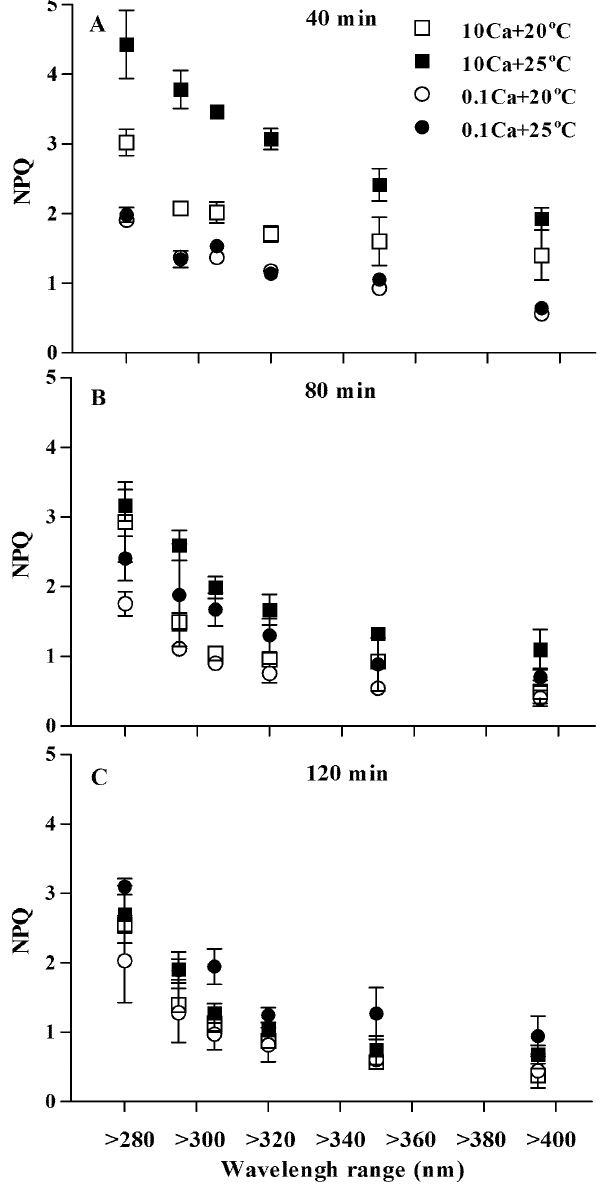
Fig. 4. Non photochemical quenching (NPQ) of Emiliania hux- leyi cells grown at HCa (squares) and LCa (circles) and exposed to different radiation and temperature treatments. Open and filled symbols are cells exposed at 20 ◦ C and 25 ◦ C, respectively. Mea- surements done after exposures to artificial radiation: (A) 40min, (B) 80min and, (C) 120min. The bars on top of the symbols repre- sent the standard deviation ( n =